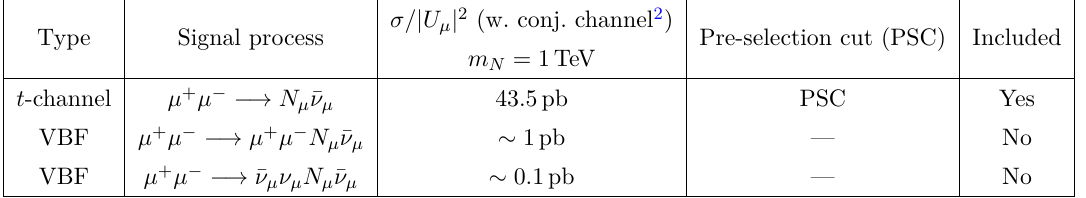
Table 1 . The signal rate for N µ at 3 TeV muon collider. The pre-selection cut is defined as: p T ( ‘ − ) > 20 GeV and | η ( ‘ − ) | < 2 . 5 where ‘ − comes from N ‘ decay. The cross-section includes the charge conjugate process.